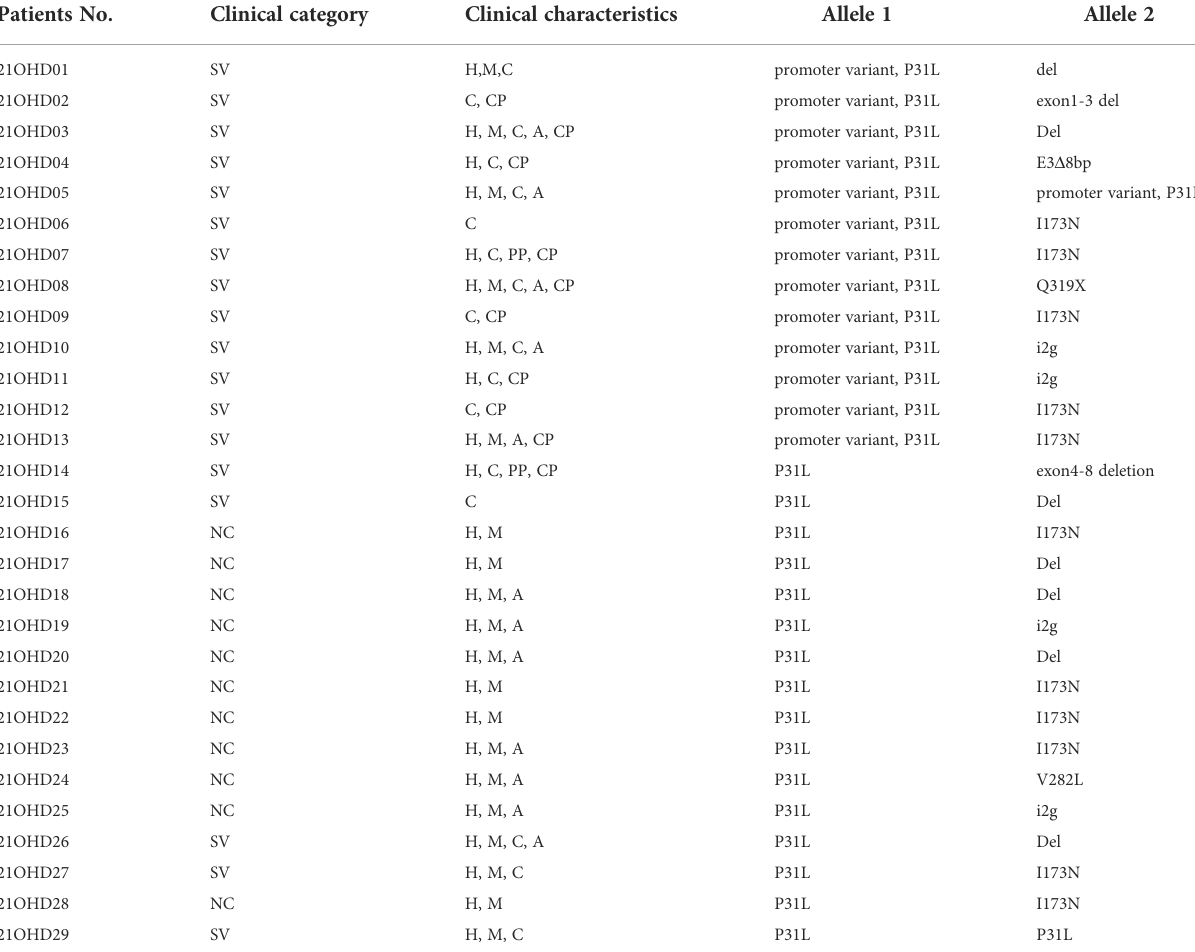
TABLE 2 Genotypes and phenotypes of 29 patients with 21-OHD harboring P31L. Patients